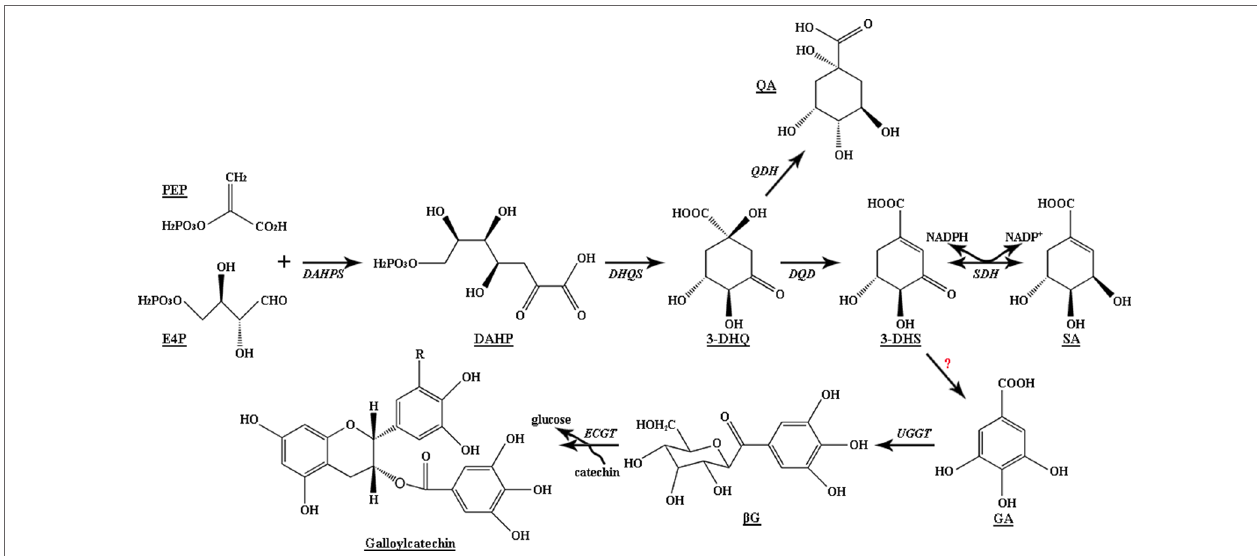
FIGURE 1 | Biosynthetic pathway of gallic acid and shikimic acid in plants. DAHPS, 3-deoxy-D-arabino-heptulosonate 7-phosphate synthase; DHQS, 3-dehydroquinate synthase; DQD, 3-dehydroquinate dehydratase; SDH, SA dehydrogenase; QDH, quinate dehydrogenase; UGGT, UDP-glucose: gallate 1- O -galloyltransferase; ECGT, epicatechin: 1- O -galloyl- β -D-glucose O